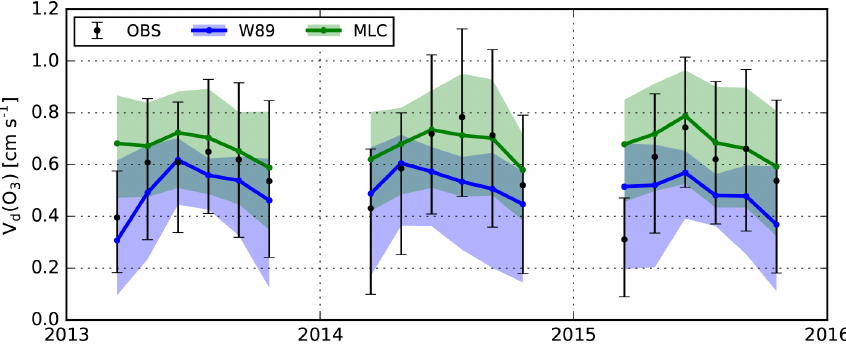
Figure 2. Time series of April–September monthly average daytime (08:00–20:00LT) ozone dry deposition velocity for Ispra, for W89 (blue), MLC-CHEM (green), and observations (black). Solid lines and points show monthly daytime medians for simulations and observa- tions, respectively, and shaded areas and whiskers display the interquartile range.